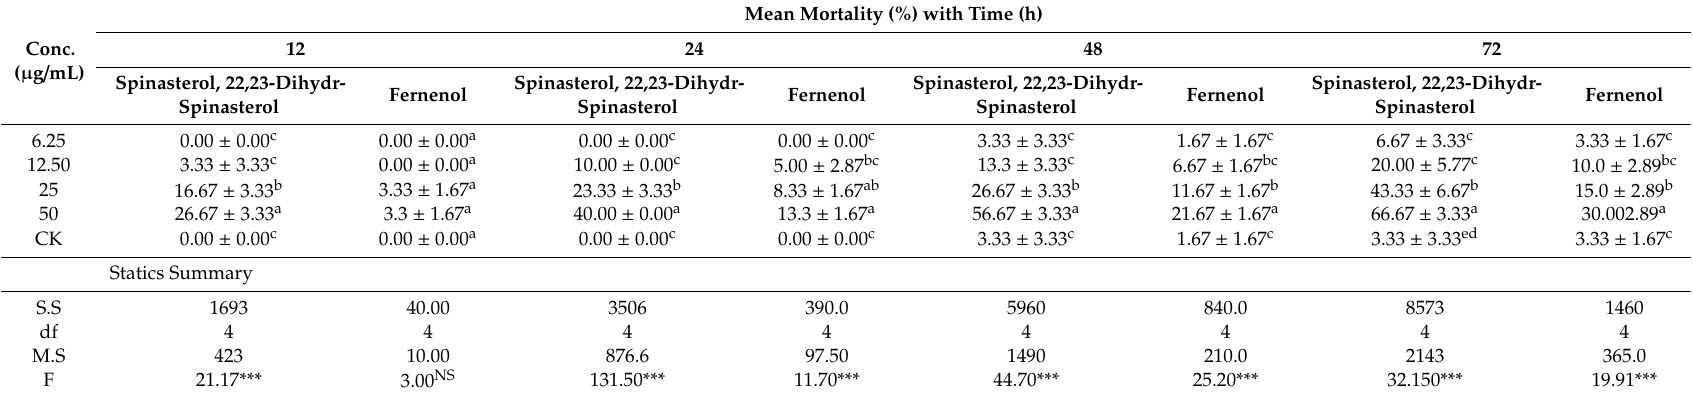
Table 2. Mortality of Brevicoryne brassicae by spinasterol, 22,23-dihydrospinasterol and fernenol via contact assay.